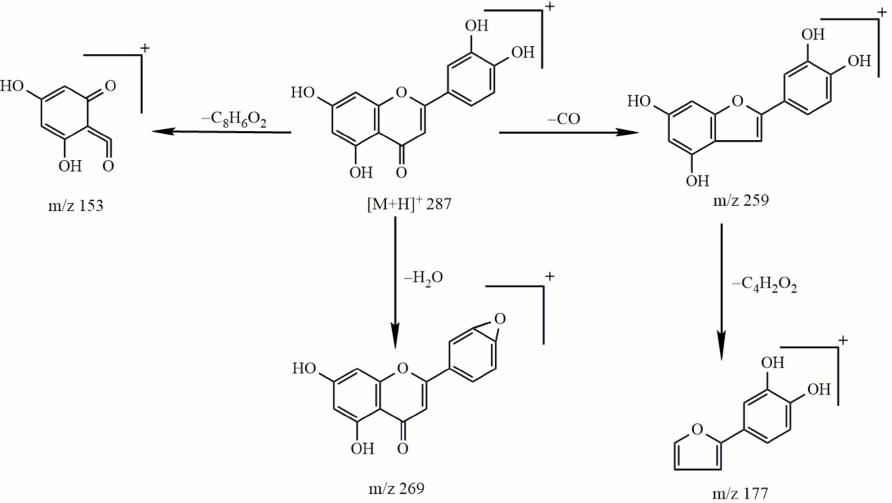
Figure 9. The cleavage pathway of